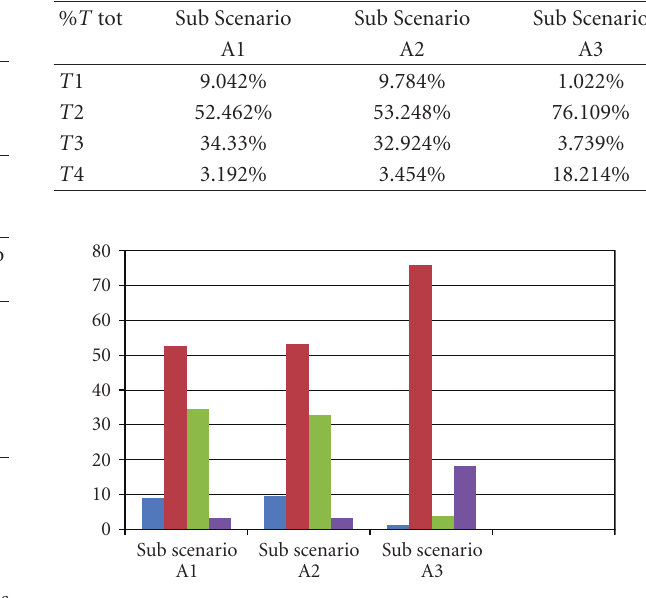
Table 5: Scenario A–BE time measurements (%)